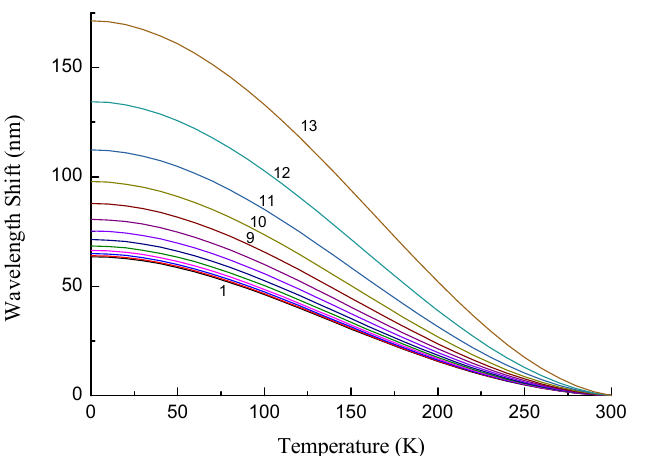
Figure 13. Wavelength shift in B/Ge#1 fiber for the resonances at 1.3 μ m as a function of temperature.